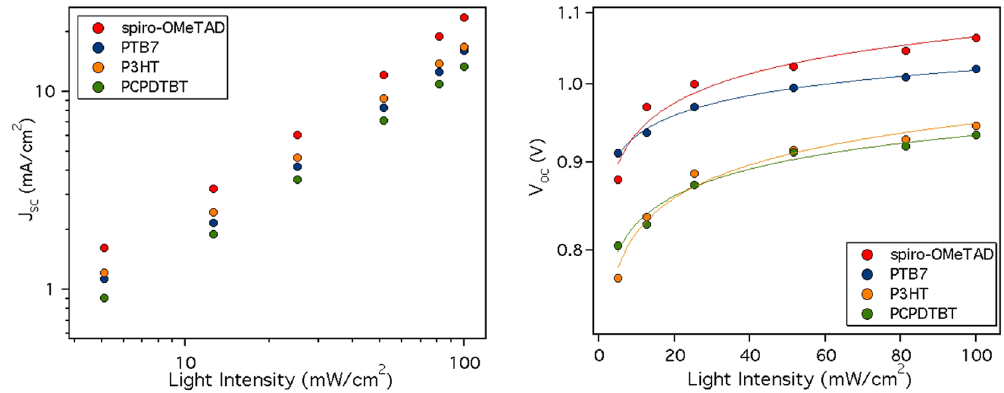
Figure 4. Light intensity dependence of J SC (left) and V OC (right) for the structure FTO/TiO 2